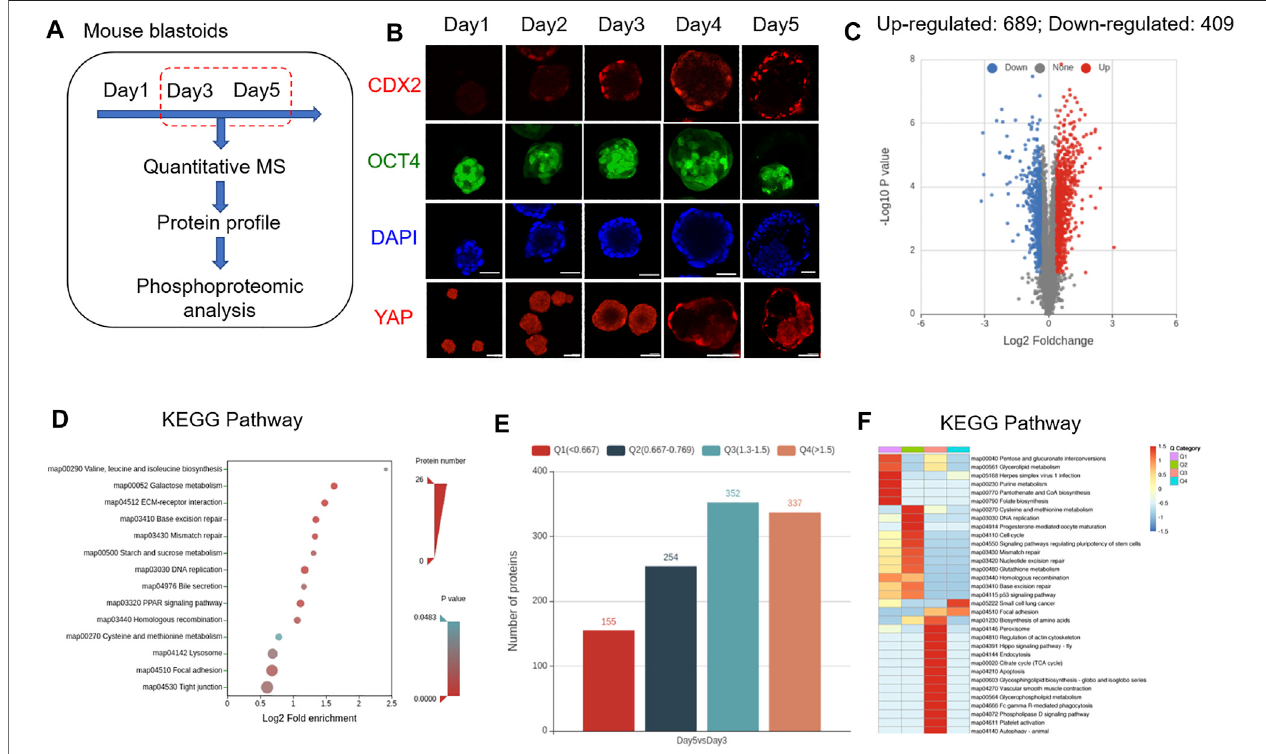
FIGURE1| Proteinexpressioncharacteristicsofmouseblastoids. (A) Diagramofblastoidcollection andLC – MS/MSanalysis. (B) Immuno fl uorescencestainingof EPS aggregates on the indicated day for CDX2, OCT4 and YAP expression. Scale bar = 50 μ m. (C) Volcano plots showing differentially expressed proteins between blastoids at Day 5 and Day 3. (D) KEGG pathway analysis of the biological processes of differentially expressed proteins. (E) The number of up- and downregulated proteins in blastoids at Day 5 compared with Day 3. The differentially expressed proteins were divided into four quanti fi ed groups based on their differential expression multiples: Q1 (0 < ratio ≤ 0.667), Q2 (0.667 < ratio ≤ 0.769), Q3 (1.3 < ratio ≤ 1.5), and Q4 (ratio > 1.5). (F) KEGG pathway enrichment of quantitative differentially expressed proteins in each Q group.